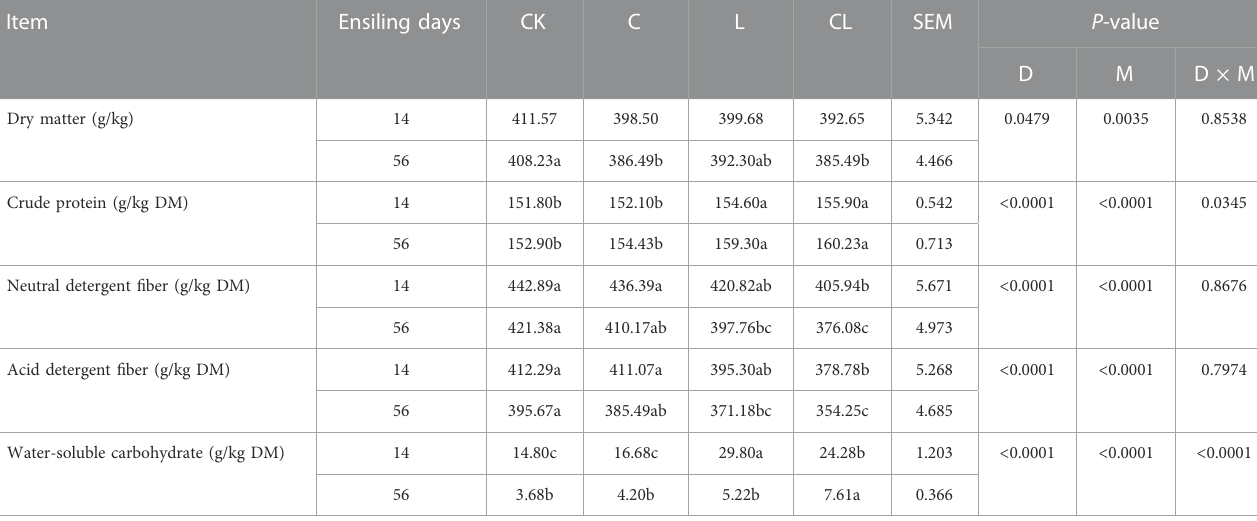
TABLE 2 Effect of cellulase and Lactiplantibacillus plantarum on the chemical composition of Caragana korshinskii silage. Item Ensiling days CK C L CL SEM